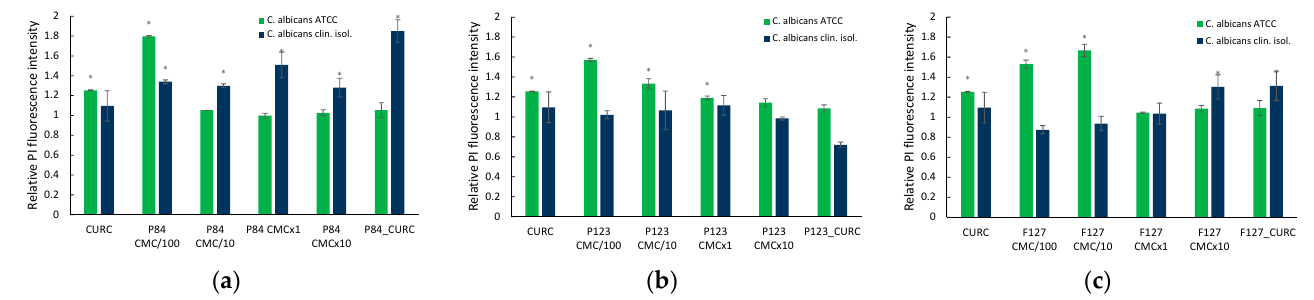
Figure 9. Relative PI fluorescence in C. albicans cultures incubated with micellar and unassociated molecules of Pluronic derivatives: Pluronic P84 ( a ); Pluronic P123 ( b ); Pluronic F127 ( c ). The con- centration of Curcumin solubilized in DMSO and in polymeric micellar dispersion is 100 μ M. Con- centrations of Pluronic derivatives were selected according to their CMC values (Table 1) to cover the micellar domain (concentrations equal to CMC and 10-fold higher) and unimer domain (con- cetrations equal to CMC/100 and CMC/10).